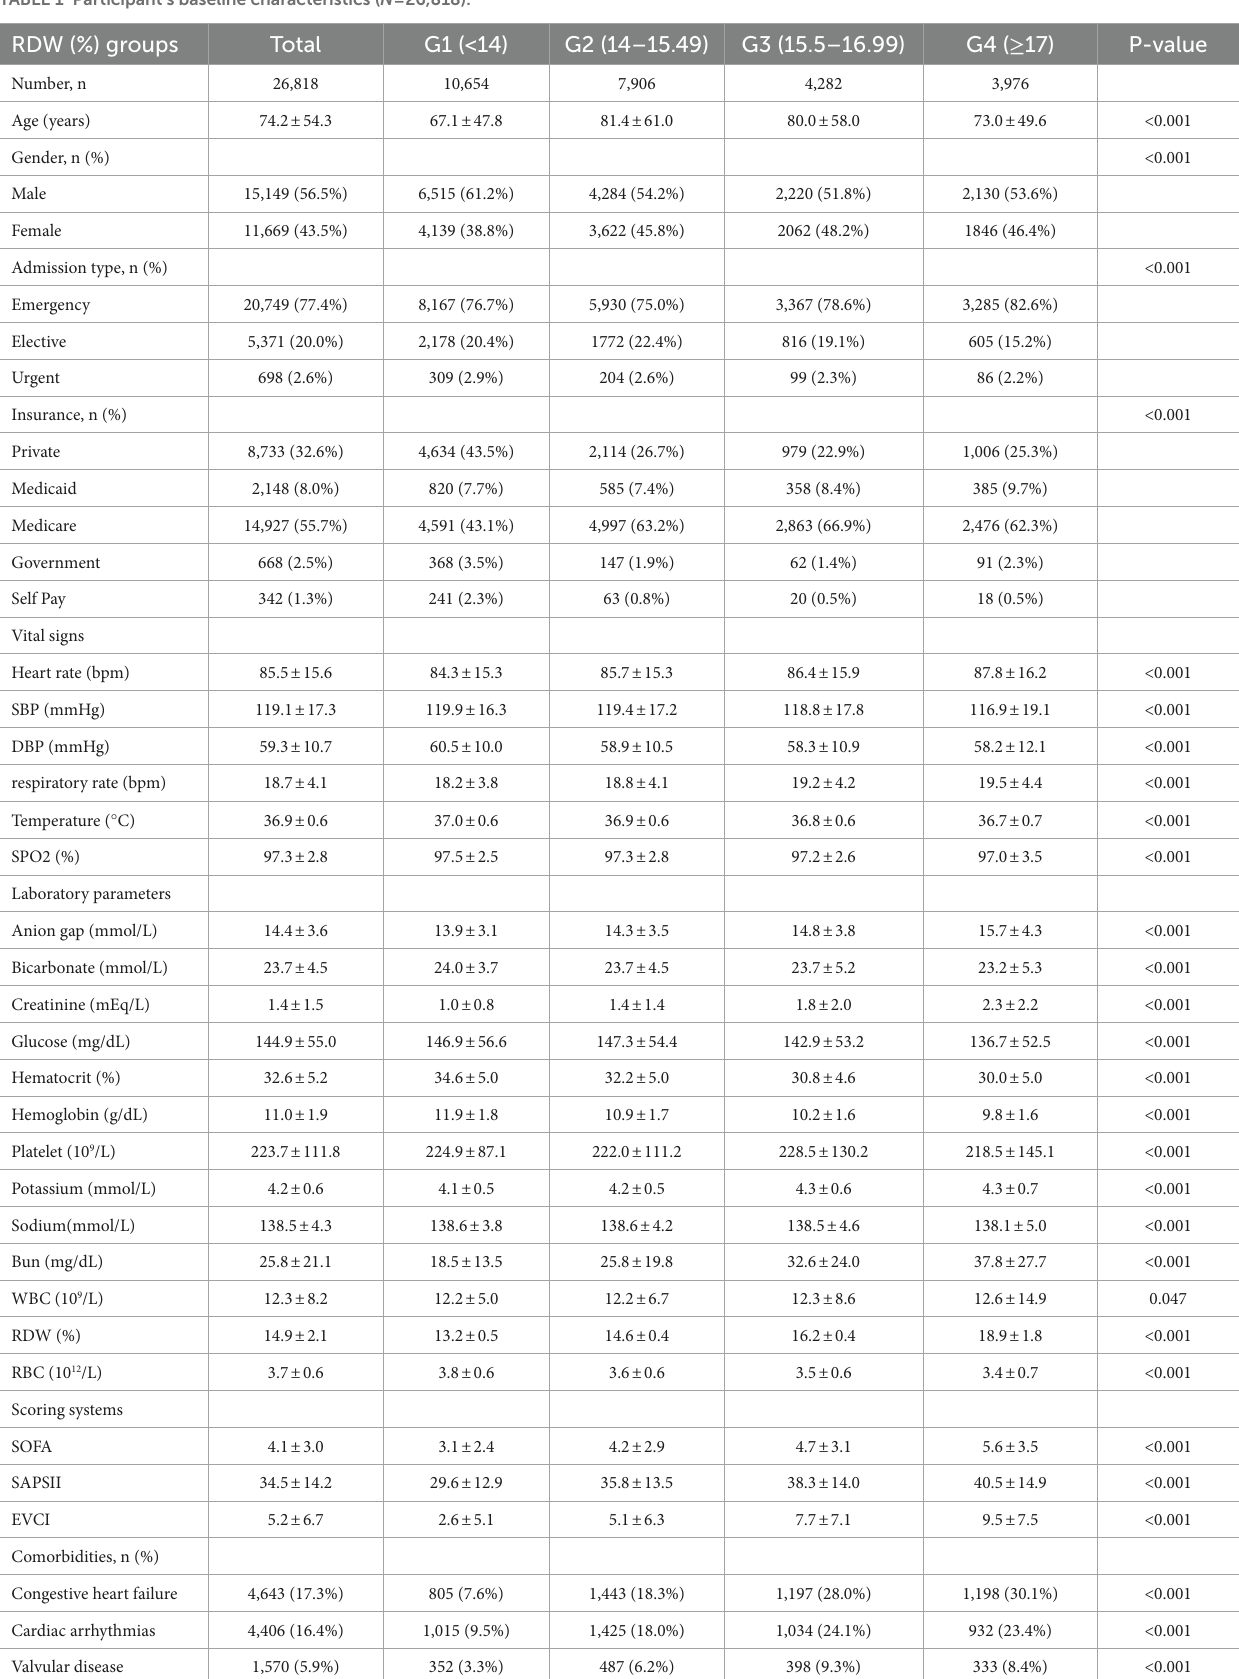
TABLE 1 Participant’s baseline characteristics ( N =